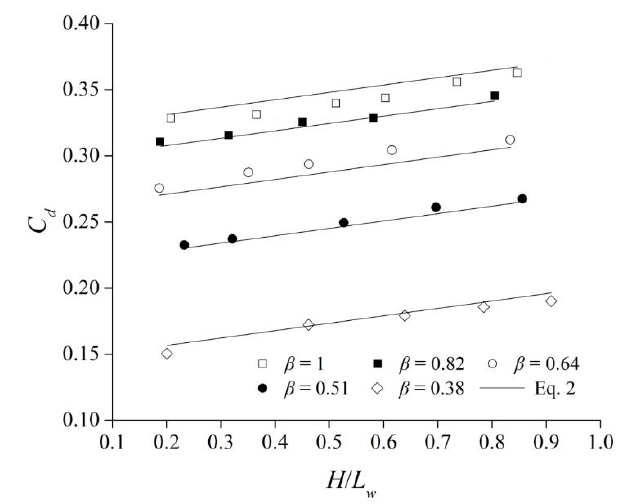
Figure 10. Compared of measured and Equation (3)-computed values.